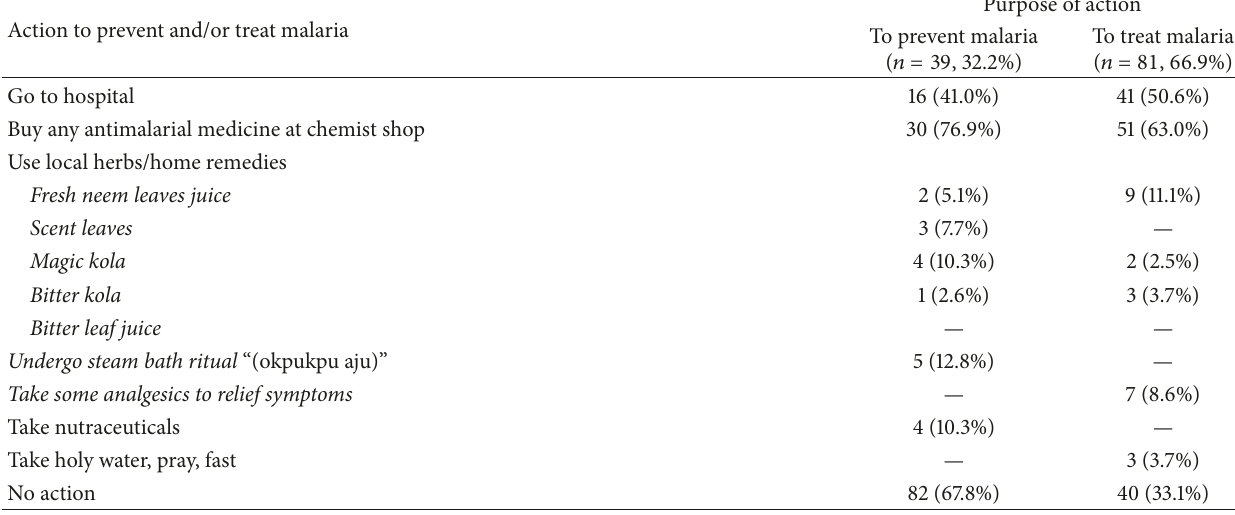
Table 4: Actions the respondents take to prevent and treat malaria infection.